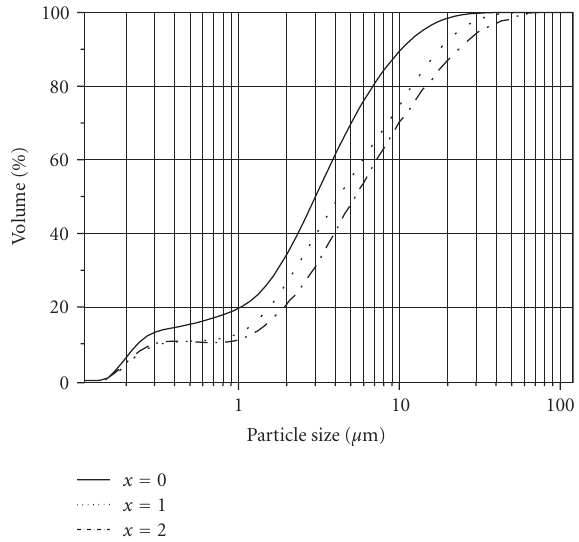
Figure 3: Particle size distribution of the as-synthesized powders.